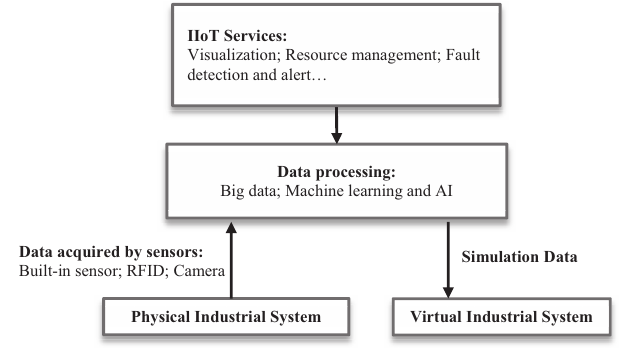
Figure 12. DT in IIoT